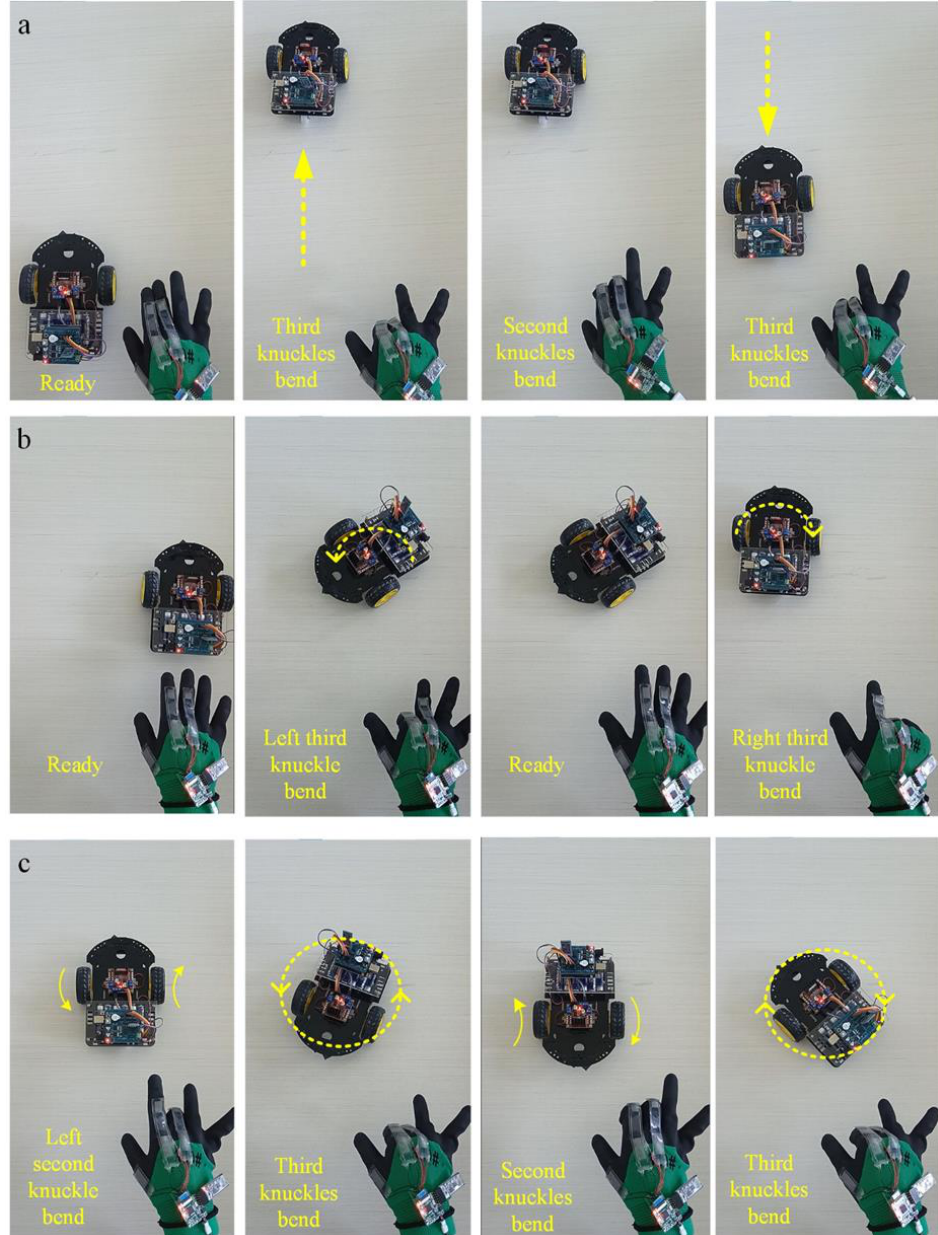
Figure 6. The sensor glove controls the motion of the Bluetooth car. ( a ) Gesture − control forward and backward for the wireless car. Change the direction of motion once. ( b ) Gesture − control left turn and right turn for the wireless car. ( c ) Gesture − control left turn and right turn for the wireless car in situ.